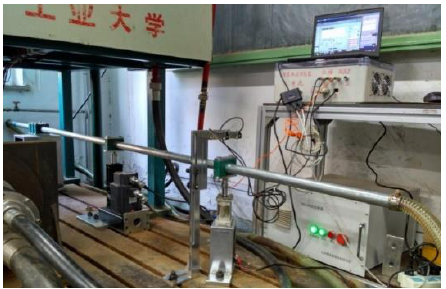
Figure 11. Pipeline vibration measurement and control system.